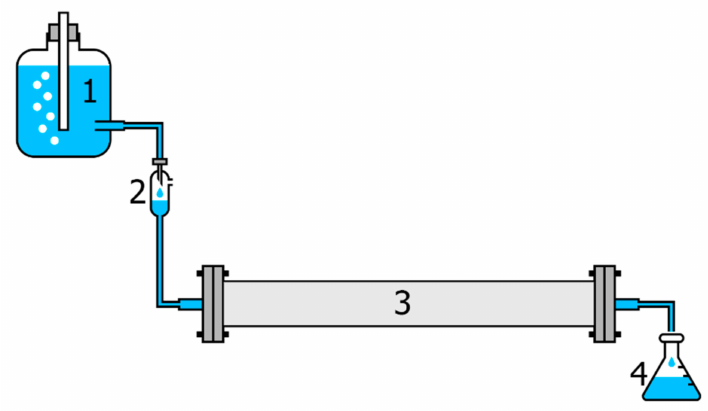
Figure 2. Schematic representation of laboratory experiment: 1—Mariotte’s vessel, 2—capillary, 3—leaching pipe, and 4—receiving tank. Table 2. Geometric parameters of the experimental setup together with rock properties.